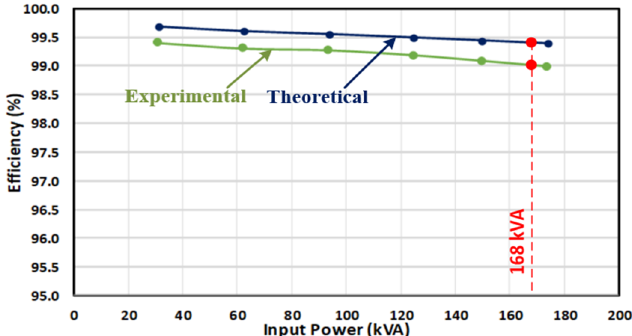
Figure 19. The variations in instantaneous efficiency of the traction converter during regenerative braking mode as a function of input kVA.